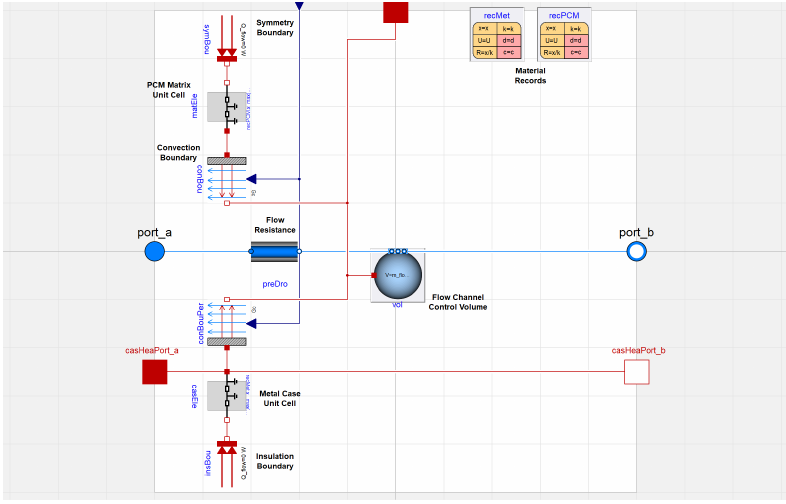
Figure 4. Full model of a perimeter element in